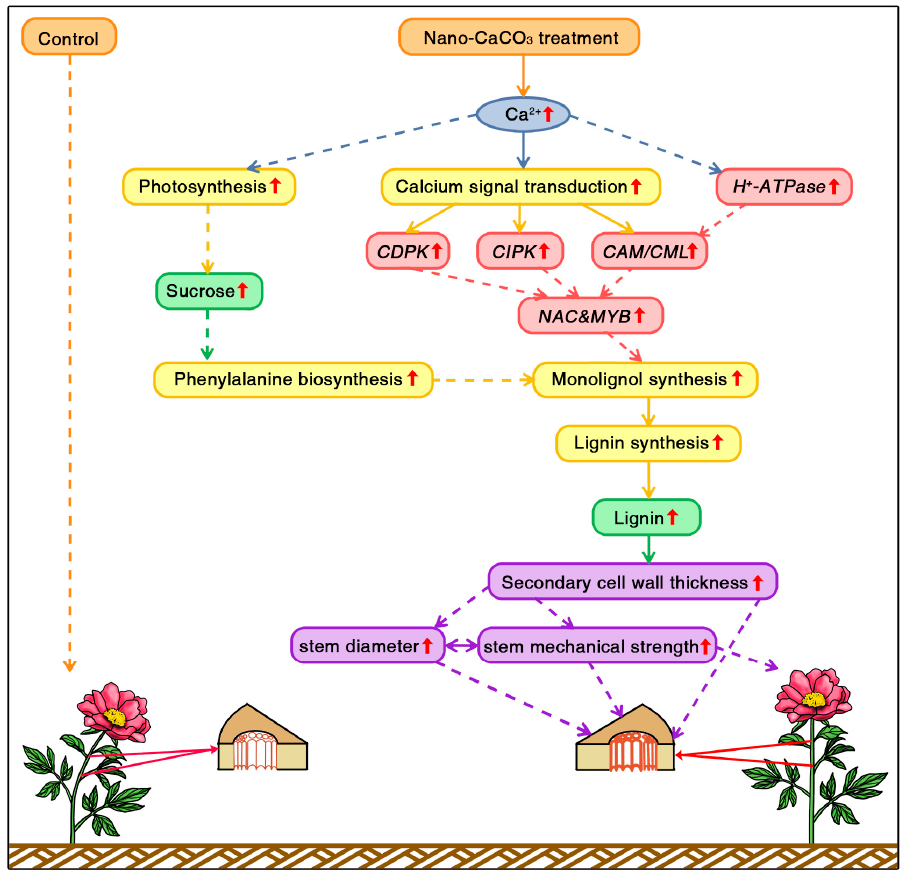
Figure 10. Proposed pathway for calcium-mediated enhancement of the mechanical strength of P. lactiflora inflorescence stems. CDPK , calcium-dependent protein kinase gene; CIPK , calcineurin B-like protein-interacting protein kinase gene; CAM , calmodulin gene; CML , CAM-like protein gene.